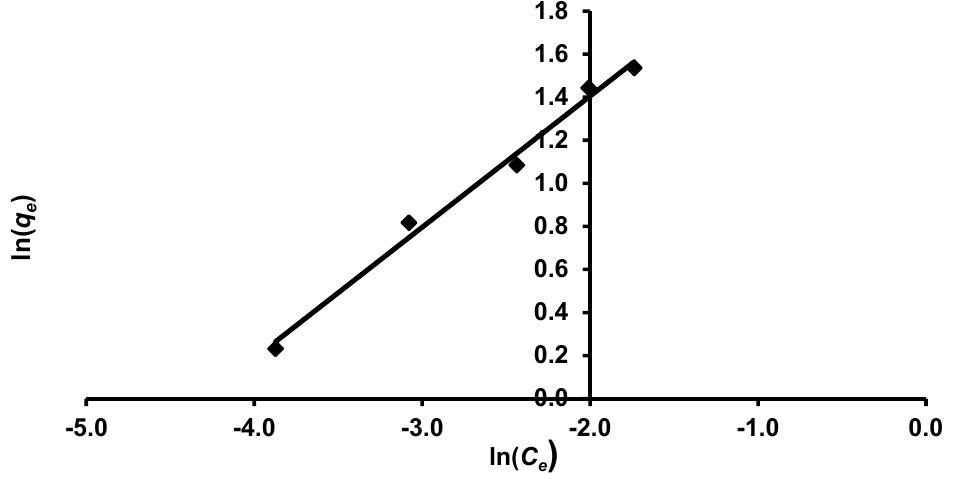
Figure 12. Linear Langmuir isotherm for the sorption of IV2R.